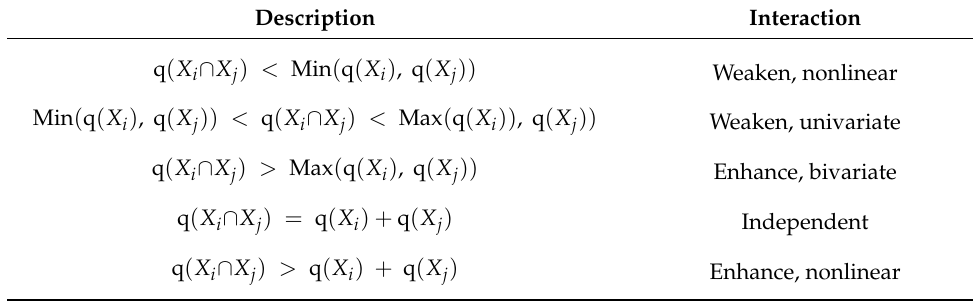
Table 2. Types of interaction: interaction between explanatory variables ( X i and X j